Question: In a single sentence, describe what this figure presents.
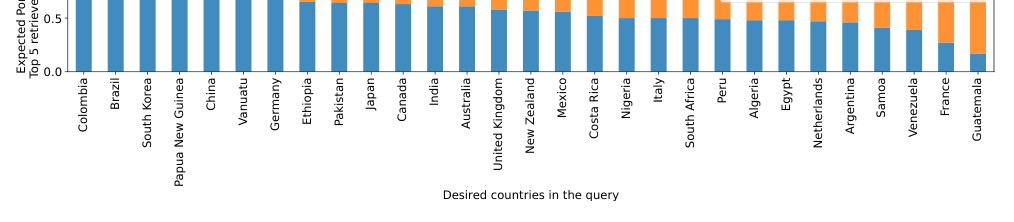
Answer: Expected portion of news articles from the desired or other countries in the top 5 retrieval results with SimCSE-sup on AGNews. Queries are from the location perspective, e.g., Find a news article on X topic and happen in Y, where Y is the desired country. We can observe that retrievers show imbalanced performance across countries. For example, users seeking news from Guatemala will experience a lower chance of satisfied retrieval than from Colombia. In the corpus, the numbers of articles per country are designed to be equal.